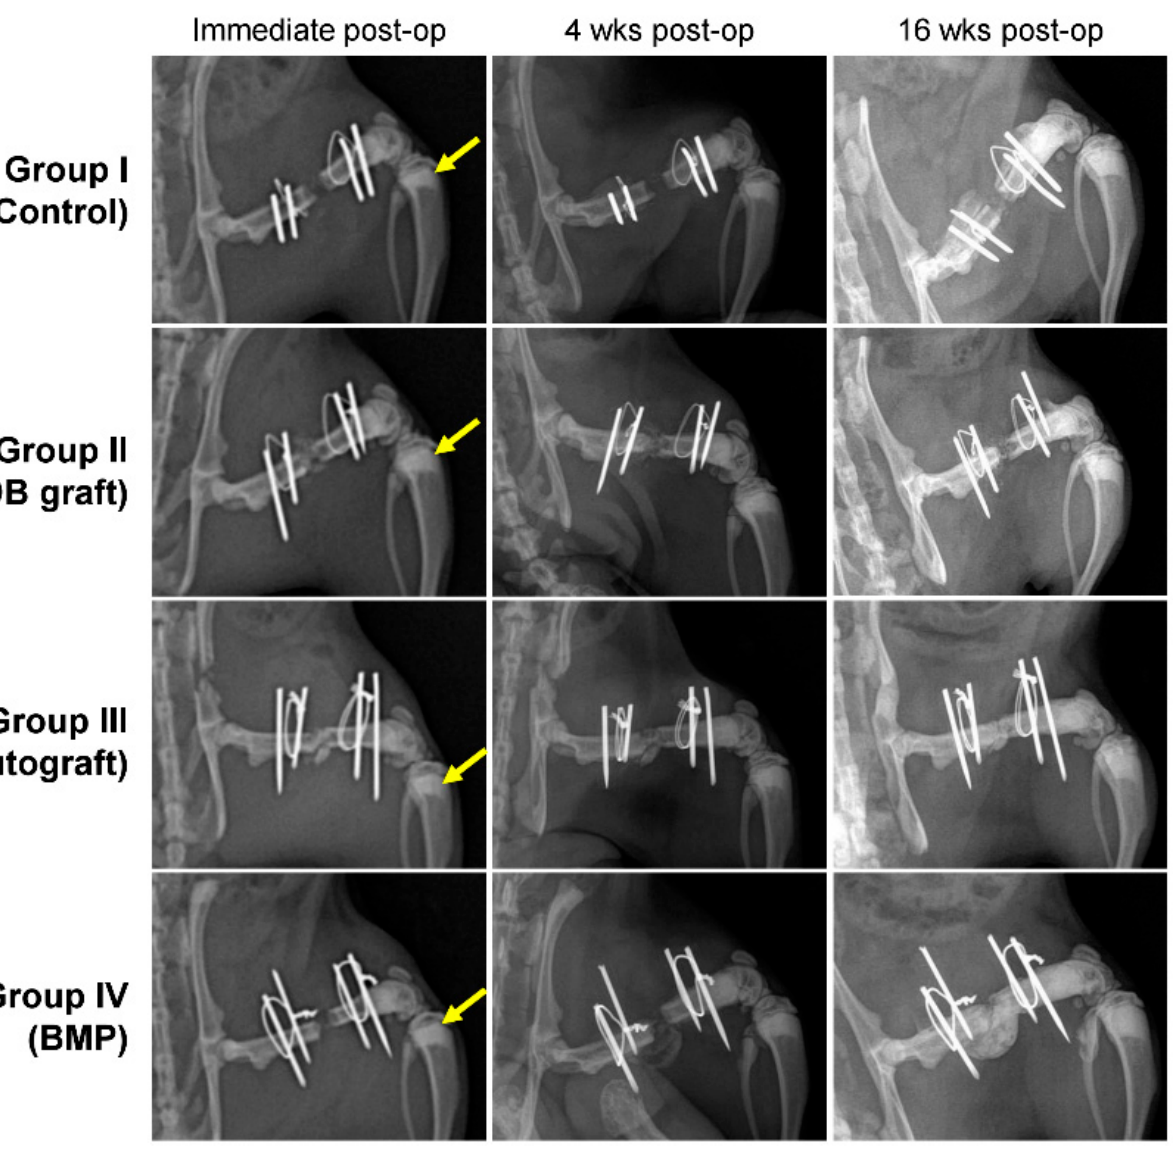
Figure 3. Radiographic findings at postoperative four and 16 weeks in each group. Groups I (Control) and II (DFDB graft) showed nonunion, while groups III (Autograft) and IV (BMP) showed unions in the femoral defects.